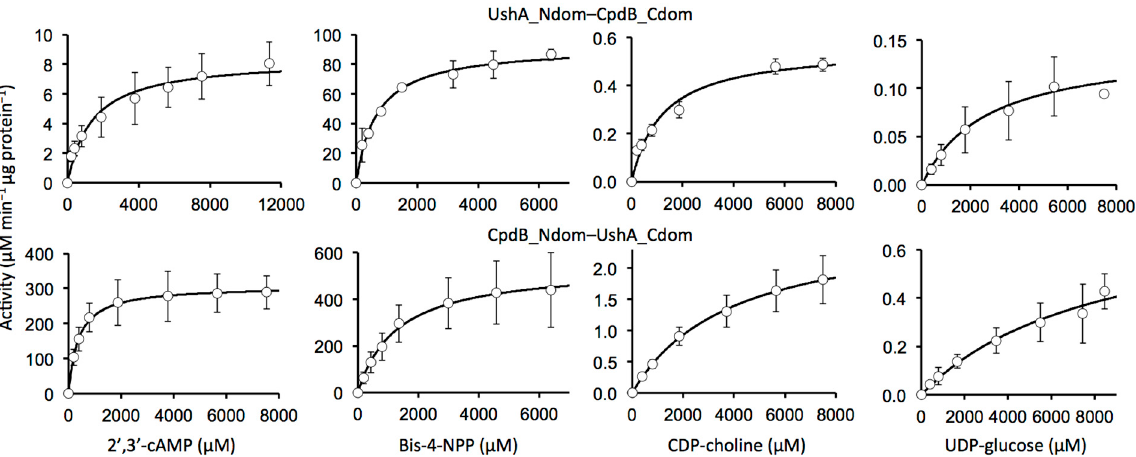
Figure 3. Saturation kinetics of chimeras with different substrates. The data points are shown as means ± standard deviations of the values that were obtained in three independent experiments. Table 1. Substrate specificity and kinetic parameters of UshA_Ndom–CpdB_Cdom and CpdB_Ndom–UshA_Cdom. All of the data for chimeras were obtained with Mn 2+ as the activating cation. The kinetic parameters were derived from the saturation curves that are shown in Figure 3. The results are expressed as mean values ± standard deviations of 3–8 rep- licates. Native-enzyme data are from earlier work (UshA [32–34]; CpdB [35]) shown here only for comparison with the chimeras: all of them correspond to Mn 2+ -dependent activities [32,35], except some UshA data that were obtained with Mg 2+ [33] or Co 2+ and Ca 2+ [34].